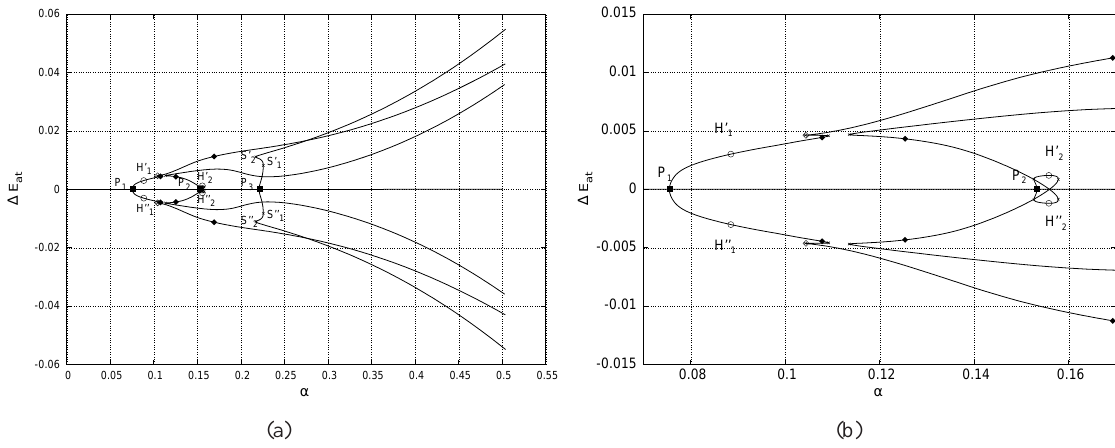
Fig. A2. Real eigenvectors corresponding to the points identified in Fig. A1: (a) pitchfork bifurcation P 3 ; (b, c) saddle-node bifurcations S 0 and S 0 ; and (d) just before the merging point M 1 . Contours every 0.1, like in Fig. 9.